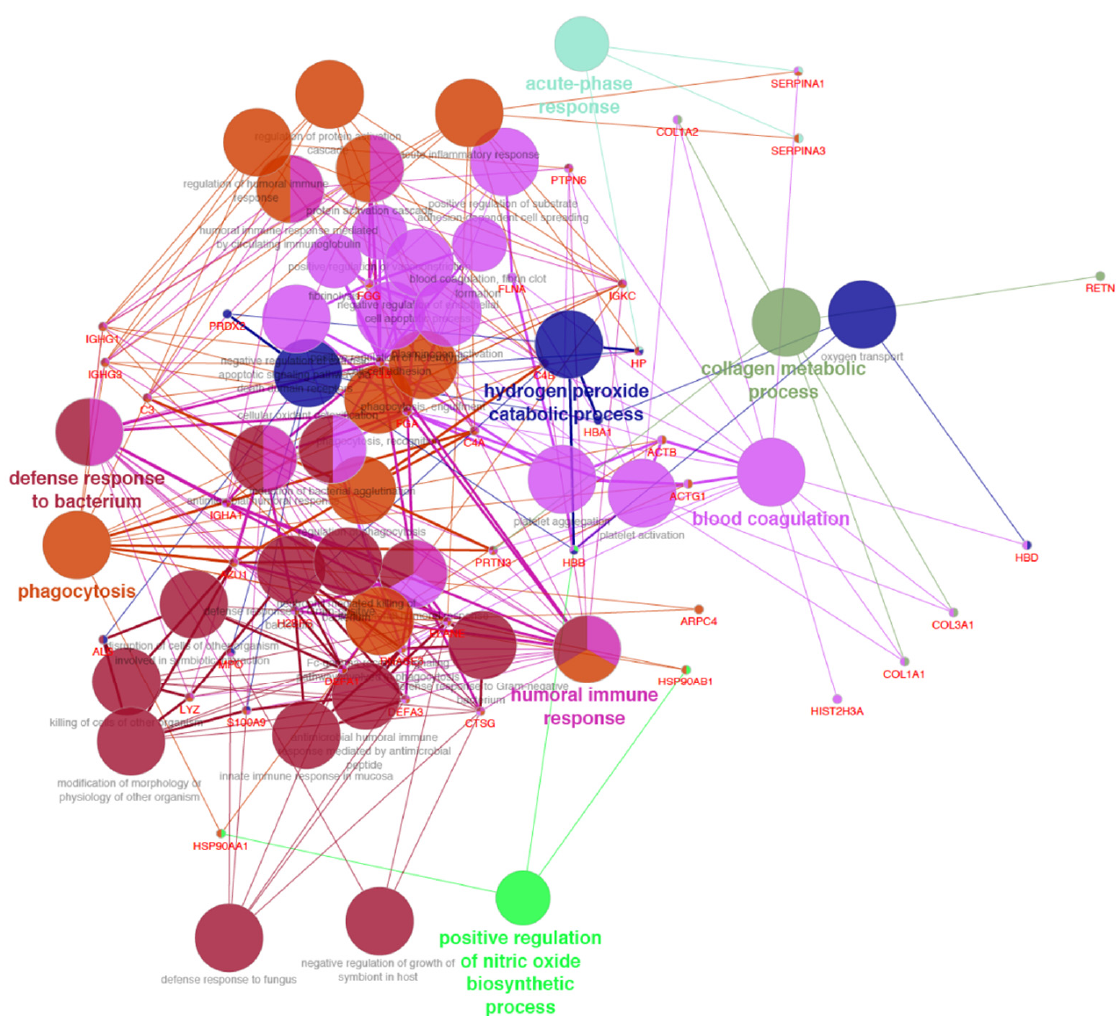
Figure 2. Cytoscape-based ClueGo pathway analysis and visualization. Enriched pathways were obtained from the Kyoto Encyclopaedia of Genes and Genome (KEGG) database. The figure reports the functionally grouped networks of identified proteins. Terms are linked based on κ -score ( ≥ 0.4); edge thickness indicates the association strength while node size corresponds to the statistical significance for each term. Biological processes are also reported.